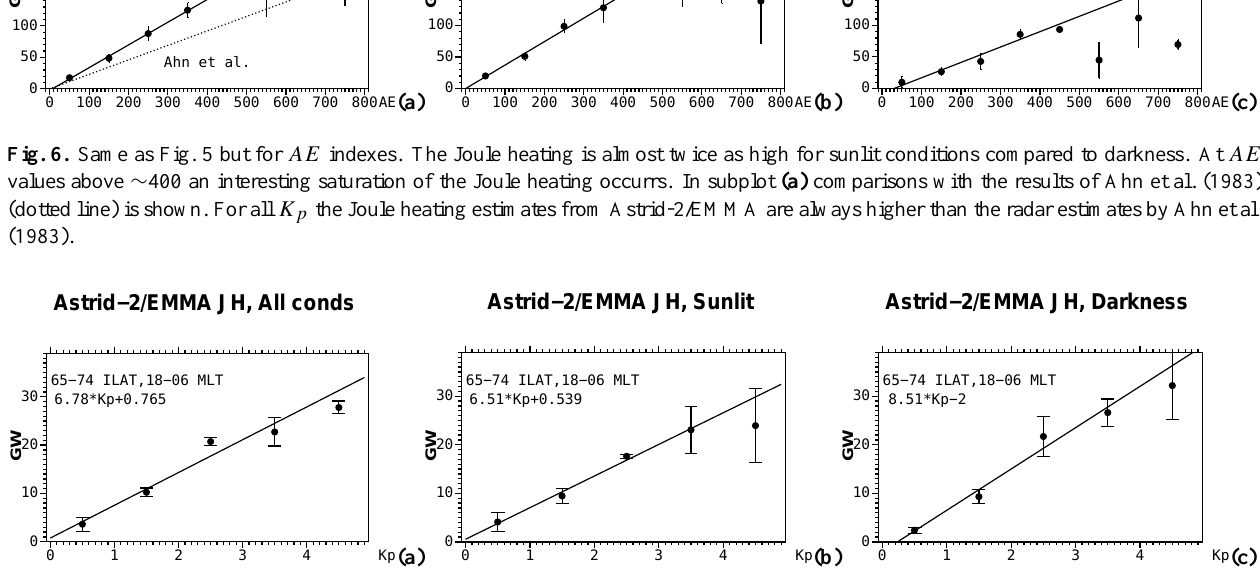
Fig. 7. The average Joule heating for the nightside (MLT 18–06) auroral zone (ILAT 65–74) for (a) all solar illumination conditions, (b) sunlit conditions and (c) darkness conditions. The solid line shows a fit to the data and the formula for the Joule heating is shown in each subplot (see also Table 1, row 7–9). The Joule heating is larger for darkness conditions especially for K p >